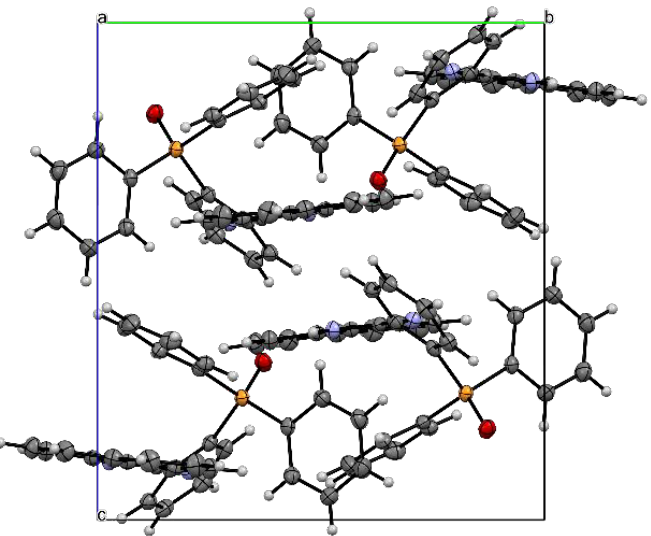
Figure 2. Packing diagram of L1 along b axis. Atom colours: (a) blue = nitrogen, (b) white = hydrogen, (c) red = oxygen, (d) orange = phosphorus, (e) grey = carbon.